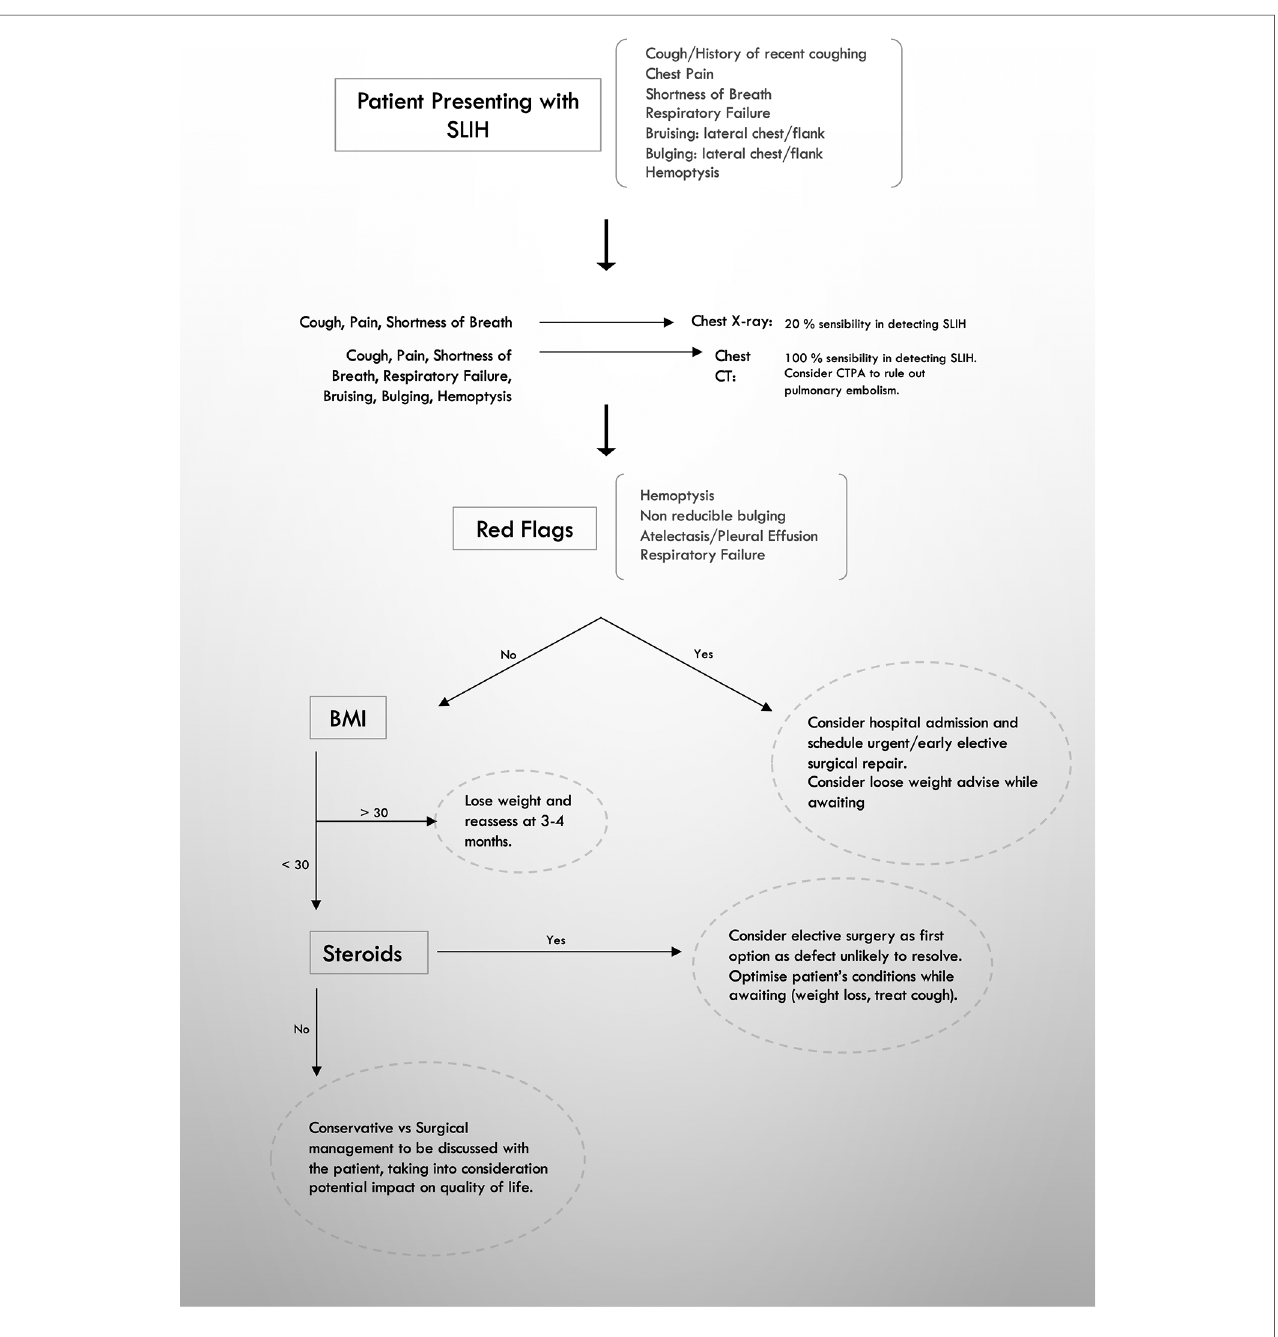
FIGURE 3 Algorithm proposal for spontaneous intercostal hernia